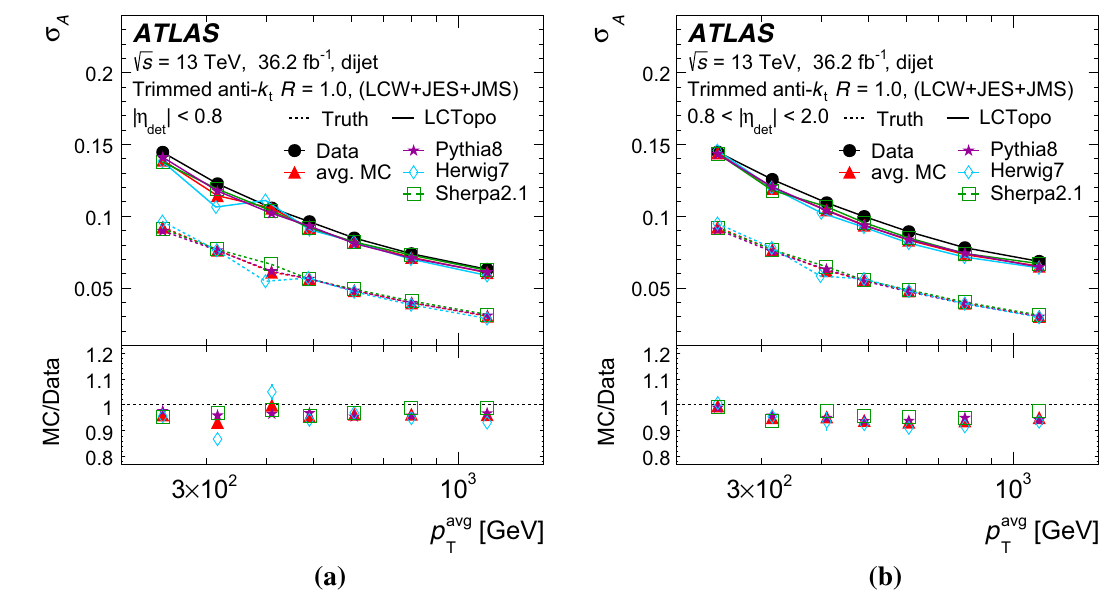
Fig. 22 Width of the dijet asymmetry distribution obtained using erators Pythia 8, Herwig 7, and Sherpa 2.1. Also an unweighted average of the three is shown. The large- R jet p T is corrected using the reconstructed ( σ A , reco ) and particle-level jets ( σ A , truth ) as a function of the average jet transverse momentum p avg simulation calibration, η -intercalibration, and a combination of in situ . Results are shown a T direct balance techniques. Statistical errors are usually smaller than the for events where both jets have detector pseudorapidity in the range | η | < 0 . 8 and b for events where the probe jet has 0 . 8 < | η | < 2 . 0, size of the marker. The resolution at the particle level is also shown as det det a dashed and the reference jet is still within | η det | < 0 . 8. The measurement is compared with the prediction from simulations based on the three gen-